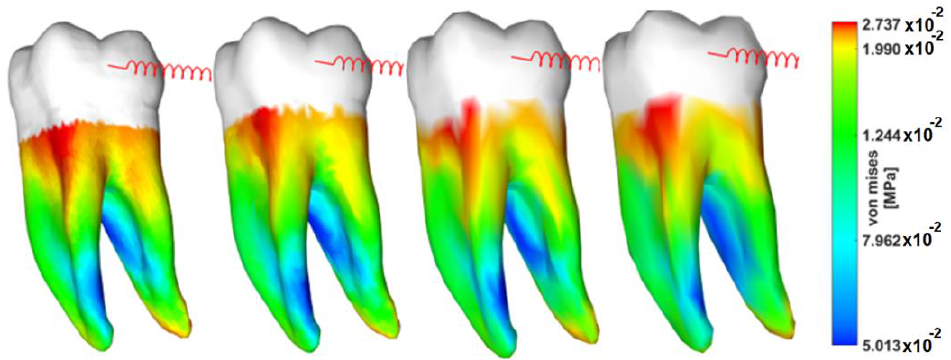
Figure 5. Facet number optimization as OTM initiated (before remodeling started) over a molar tooth. The red spiral represents the external force.